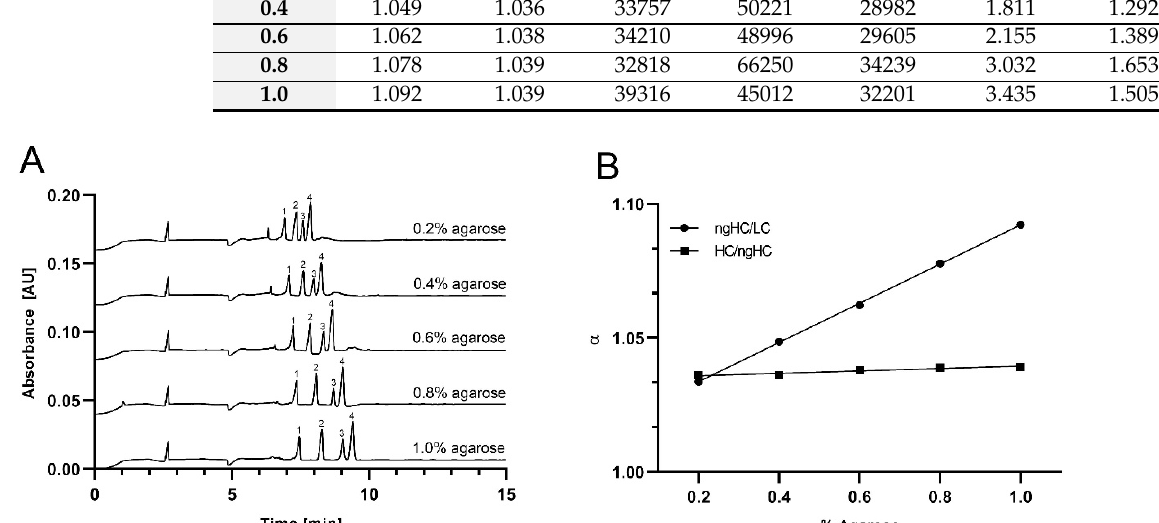
Figure 3. Separation of the SDS-omalizumab subunit complexes in increasing agarose concentration gels with 640 mM TBE background electrolyte ( A ). The agarose concentration-based selectivity changes between the ngHC/LC, and HC/ngHC fragments are shown in panel ( B ). Peak assignment and separation conditions were the same as in Figure 1.